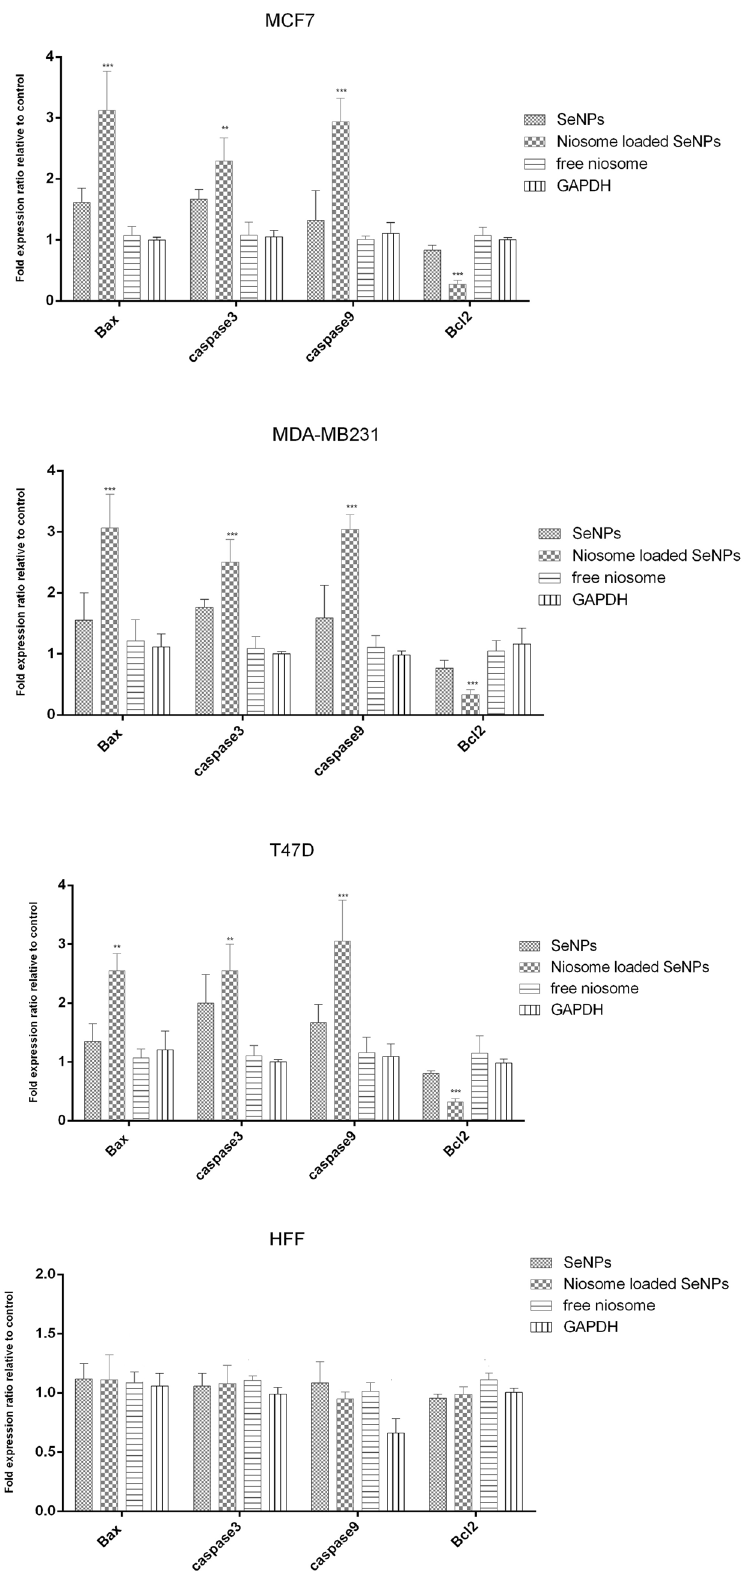
Figure 8. Apoptosis gene expression analysis in breast cancer cell lines and normal cells after treatment with free niosome, free SeNPs, and noisome-loaded SeNPs. n = 3, *** p < 0.0001; ** p <